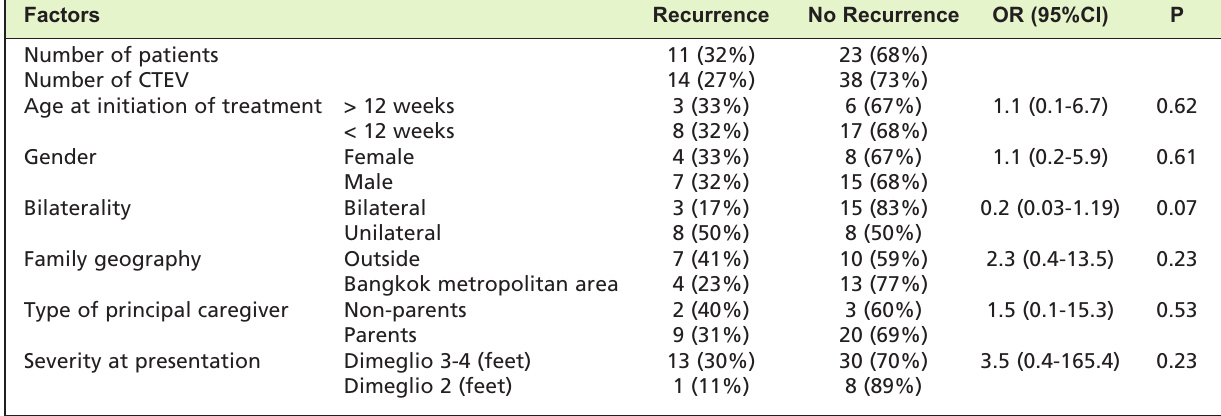
Treatments associated factors related to recurrence of idiopathic congenital talipes equinovarus post the Ponseti method